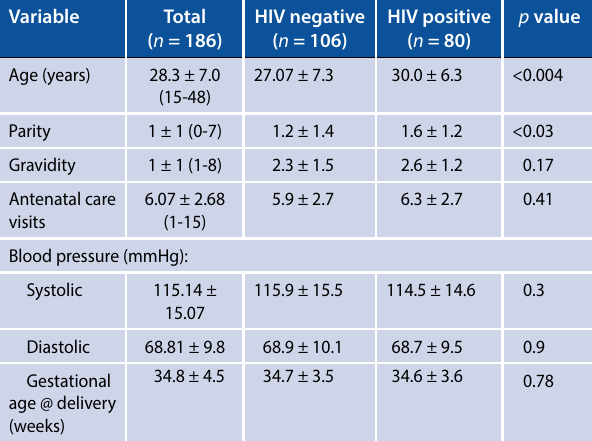
Table 1: Demographic and clinical data of HIV uninfected and HIV infected women with twin pregnancies Variable